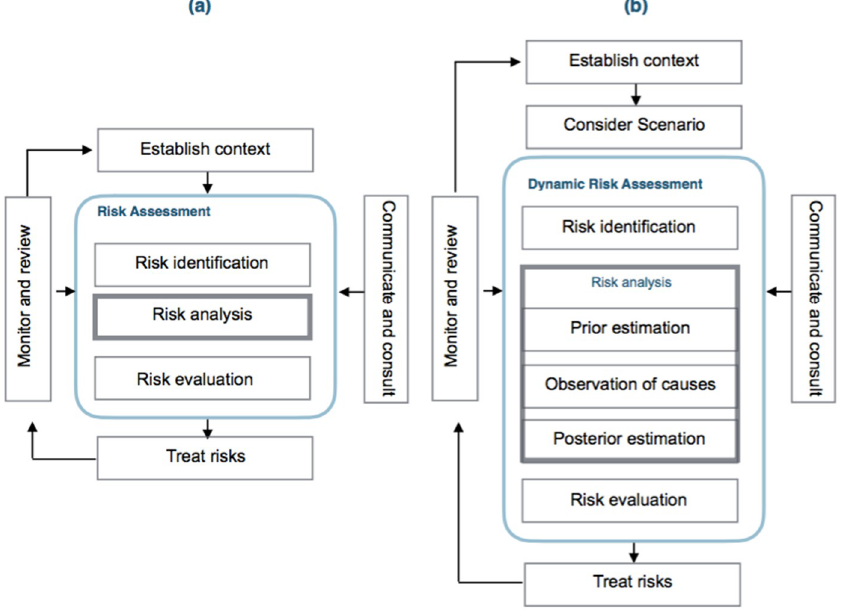
Table 4. Existing dynamic